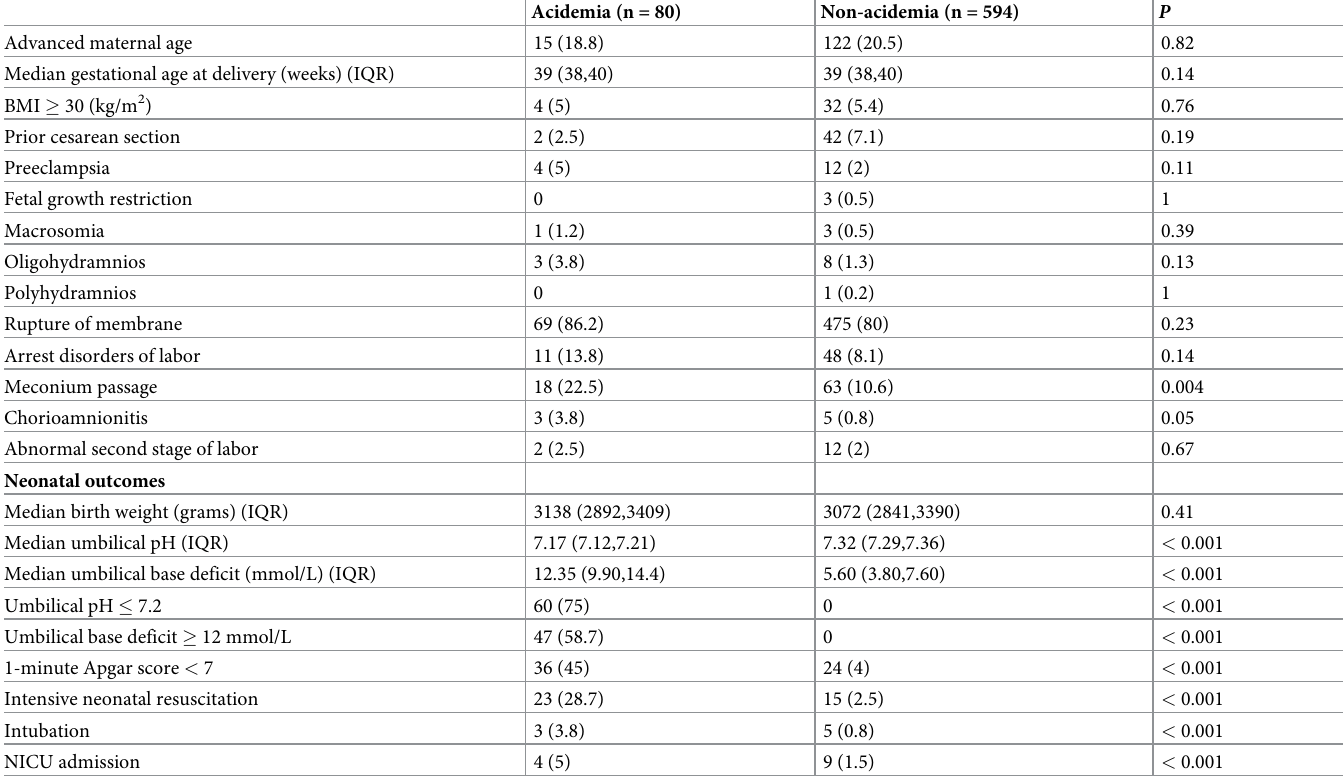
Table 1. Baseline characteristics, antepartum and intrapartum variables, and neonatal